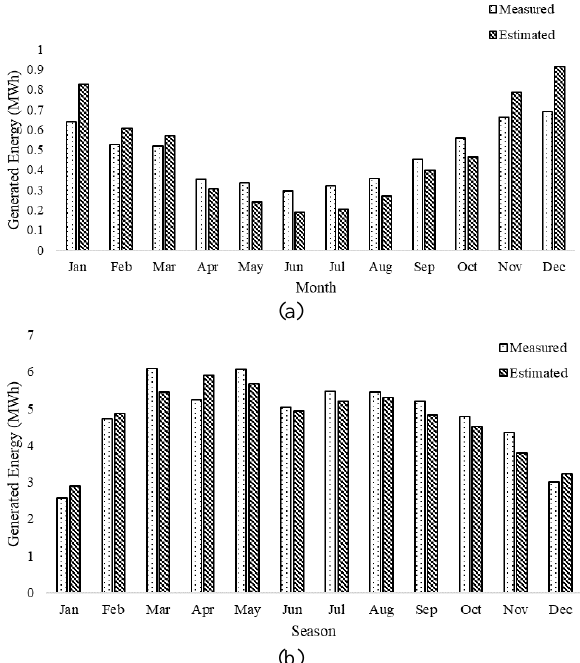
Figure 9. Comparison of estimated (effective) and measured energy in: (a) Signal Hill (SH) and (b) Bangkok Frecon